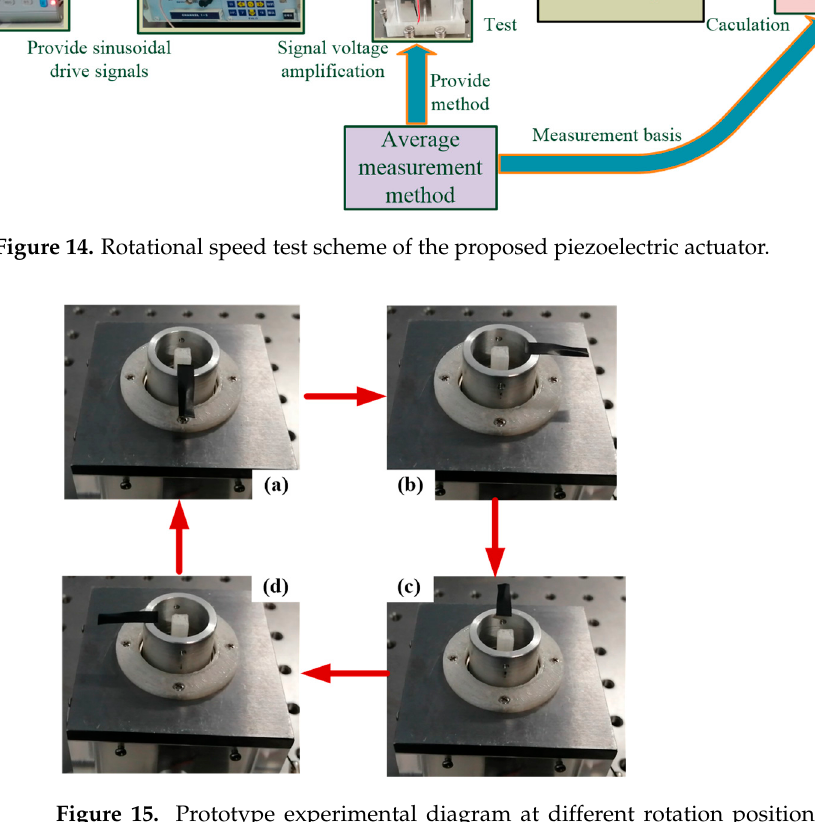
( a ) ( b ) Figure 16. Rotational speed test results of the piezoelectric actuator. ( a ) The change of rotation speed with driving voltage at different frequencies; ( b ) The speed varies with frequency. The research results verify the feasibility of the proposed low-frequency harmonic piezoelectric actuator. Meanwhile, the investigation in this paper lays a theoretical and experimental foundation for the improvement of the piezoelectric actuator. Compared with the harmonic piezoelectric motor developed by Barth [21], the proposed harmonic piezoelectric actuator in this paper just uses two 5 × 5 × 30 mm pie- 01234 56